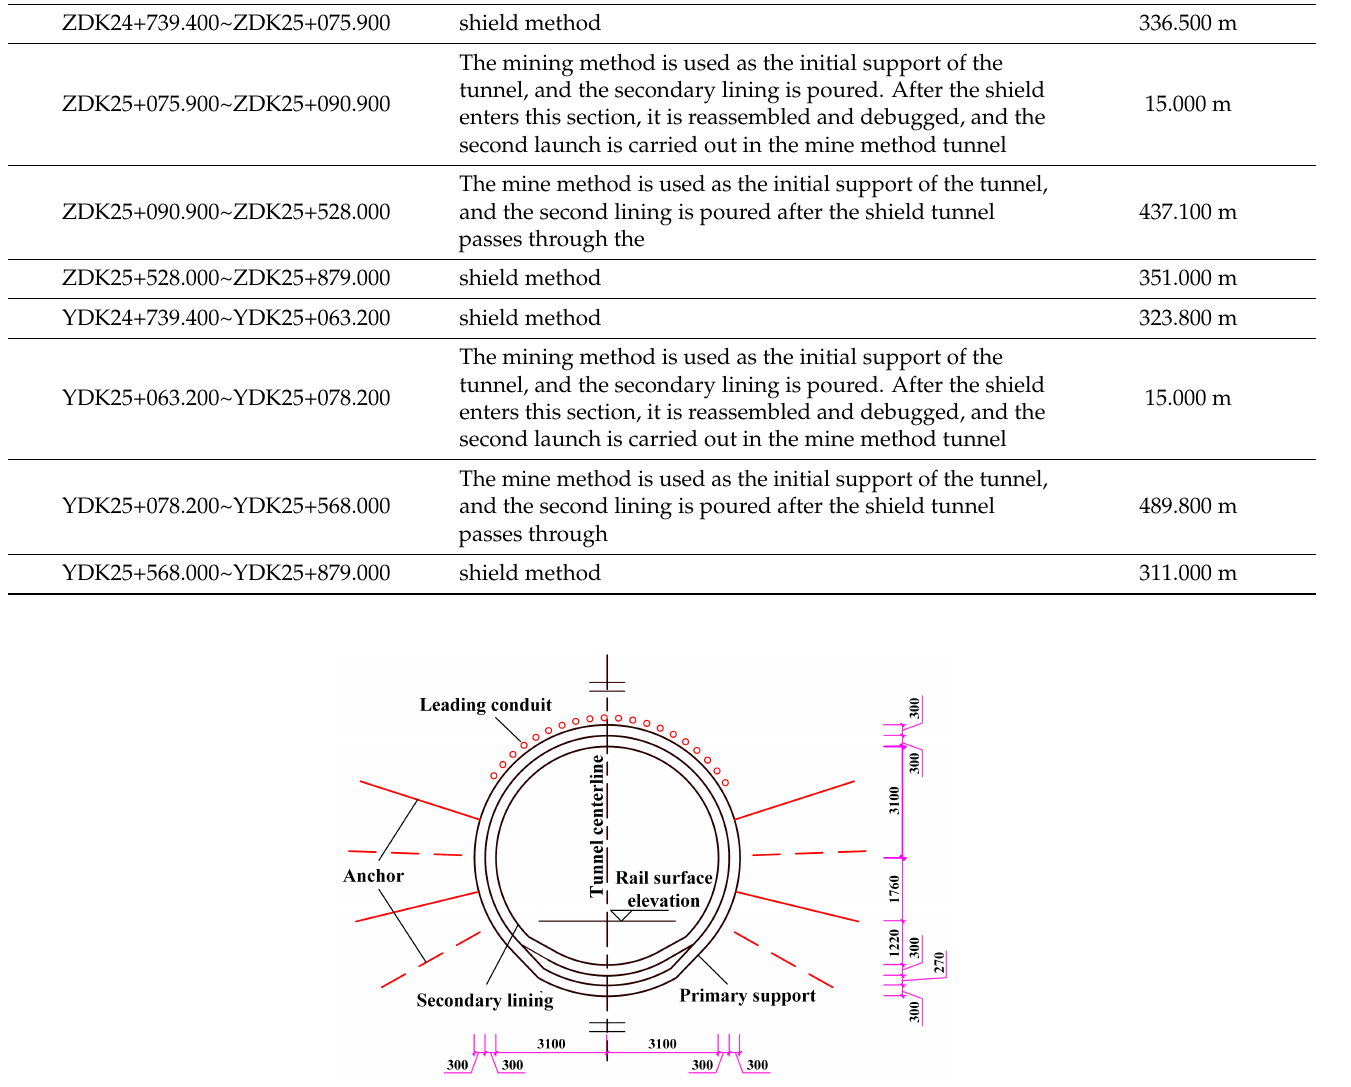
Figure 3. Tunnel section and support parameters (unit: